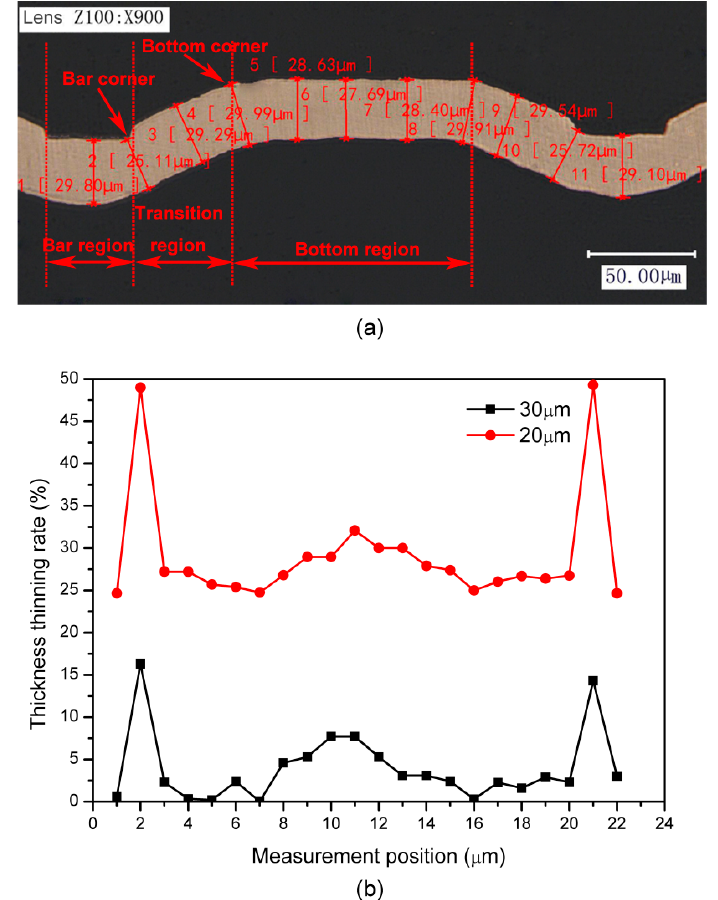
Figure 28. ( a ) The measurement method and thickness distribution of several locations and ( b ) the thickness thinning rate distribution of the microchannel with the thickness of 20 μ m and 30 μ m under the laser energy of 1800 mJ.